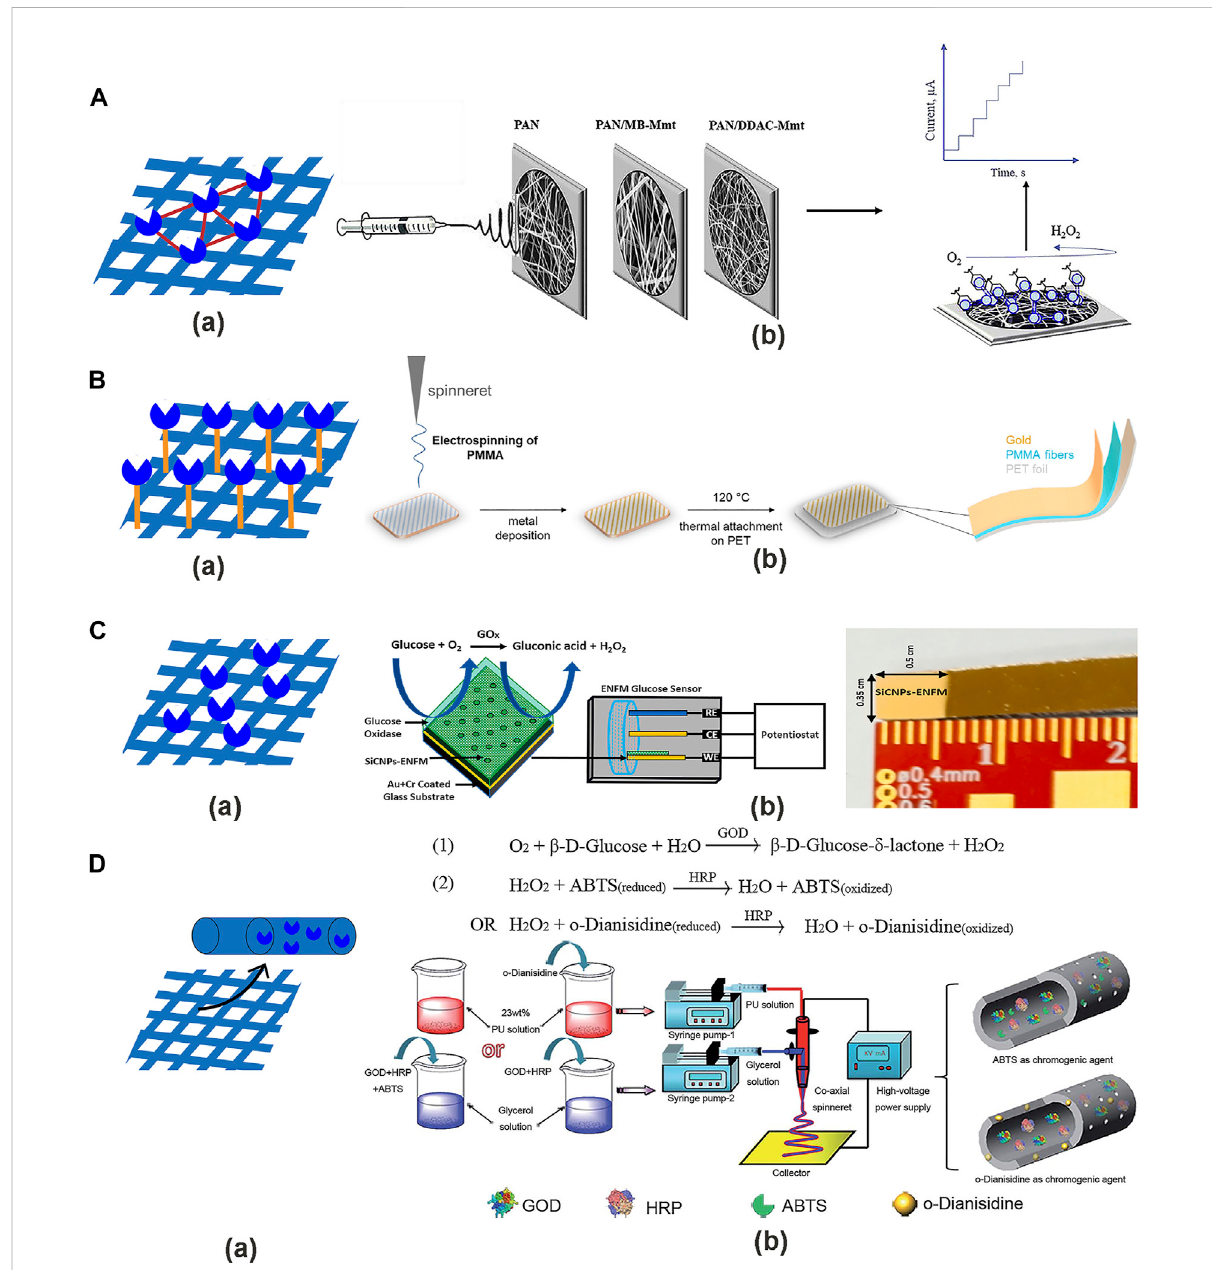
FIGURE 8 The enzyme immobilization methods on the NFs. (A) (a) Cross-linking method. (b) Fabrication of electrospun PAN/Mt NFs with MB-Mt or DDAC-Mt and immobilized the GOx by cross-linking method (Apetrei and Camurlu, 2020). (B) (a) Covalent bonding method. (b) Fabrication of Au/ PMMA/PET electrode by covalent bonding method (Aldea et al., 2021). (C) (a) Adsorption method. (b) SiCNPs-ENFM glucose-sensing electrode immobilized with GOx by adsorption method and photo of the ENFM sensor electrode (Puttananjegowda et al., 2021). (D) (a)